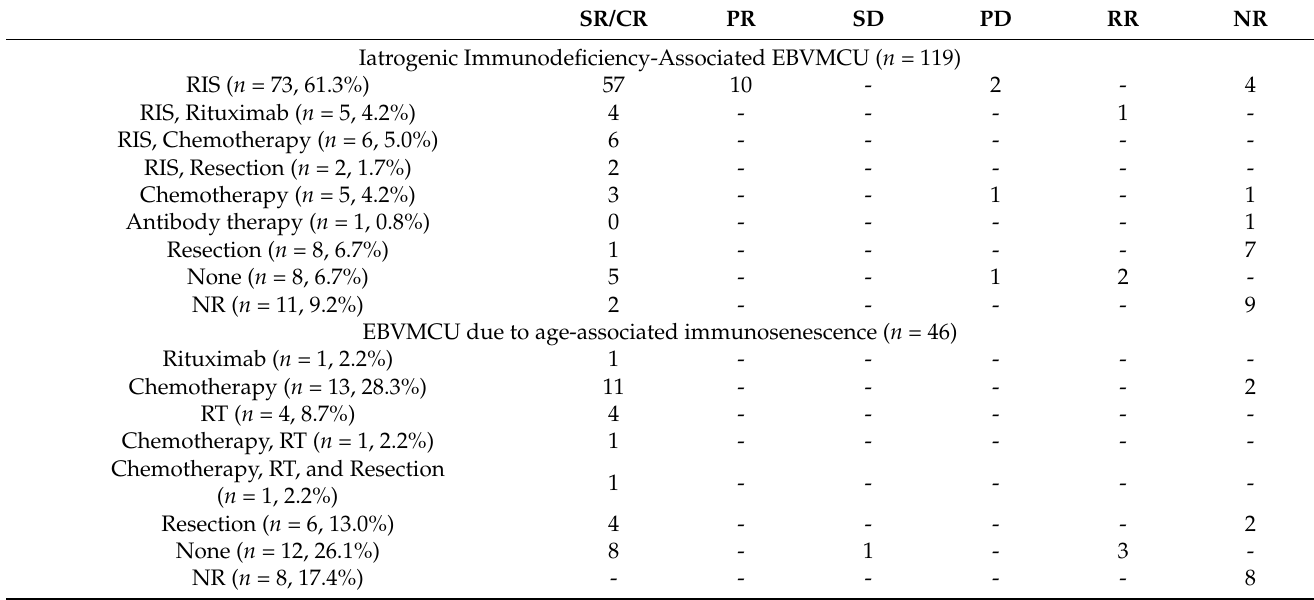
Table 3. Treatment and clinical courses of 186 EBVMCU cases (2010–2020) [5,15–23,25–69].